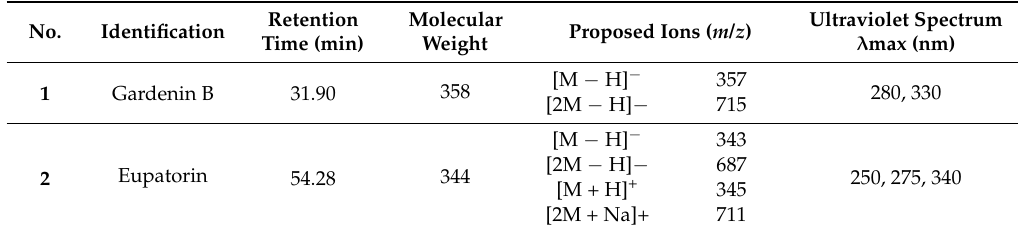
Table 1. The identification, retention time, MS and UV data of screened compounds.